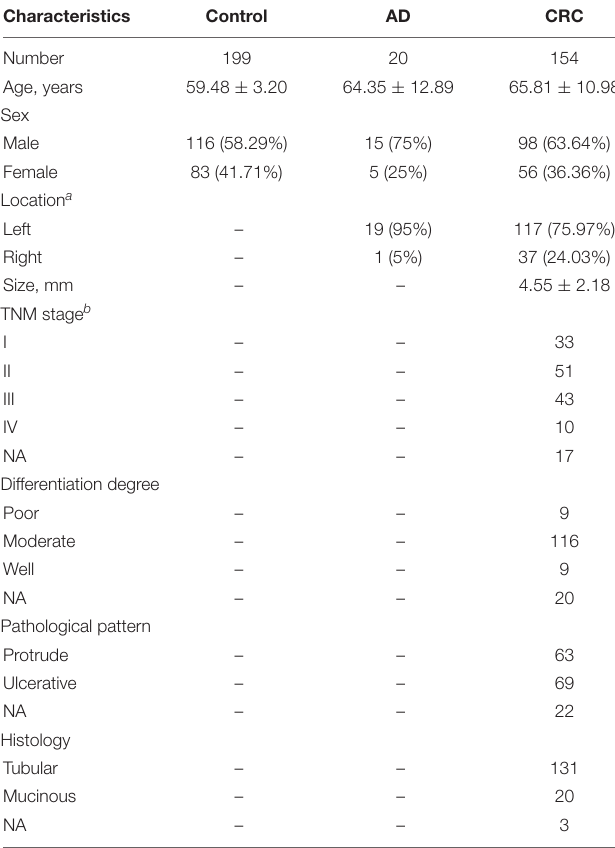
TABLE 1 | Demographic and clinical characteristics of patients and